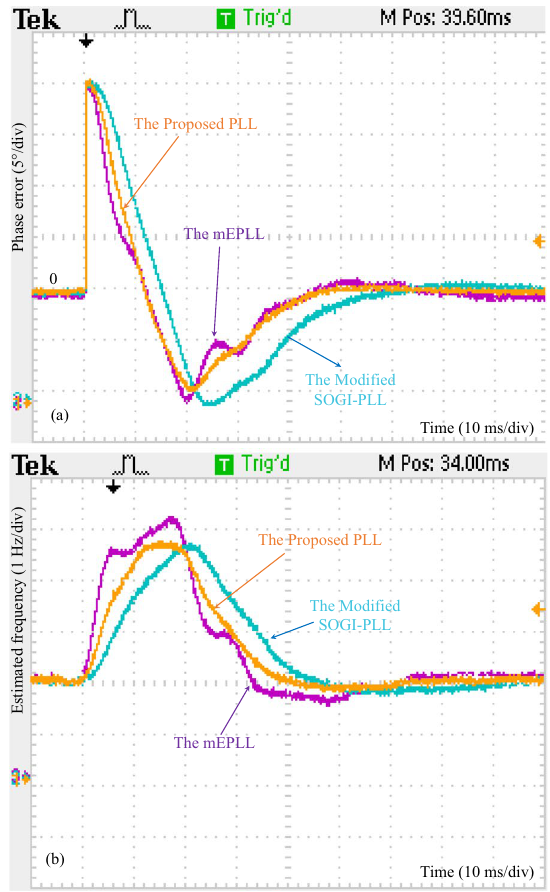
Fig. 14 Experimental results under a 20° phase jump. CH1, CH2, and CH3 show the responses of the proposed PLL, mEPLL, and modified SOGI-PLL, respectively. a Estimated phase error and b estimated grid frequency